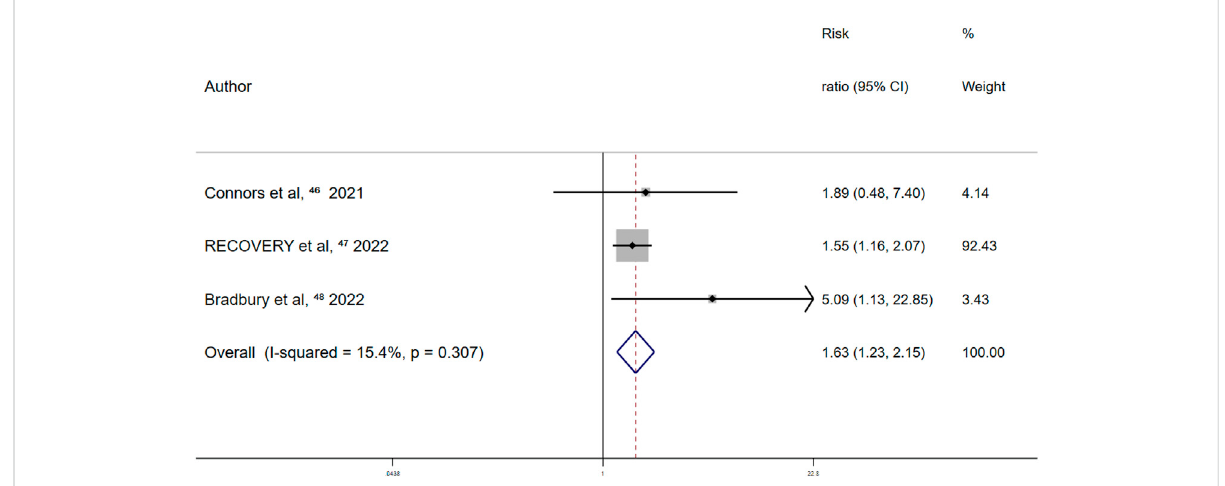
FIGURE 7 Summary hazard ratio of bleeding events for aspirin use in randomized controlled trials.